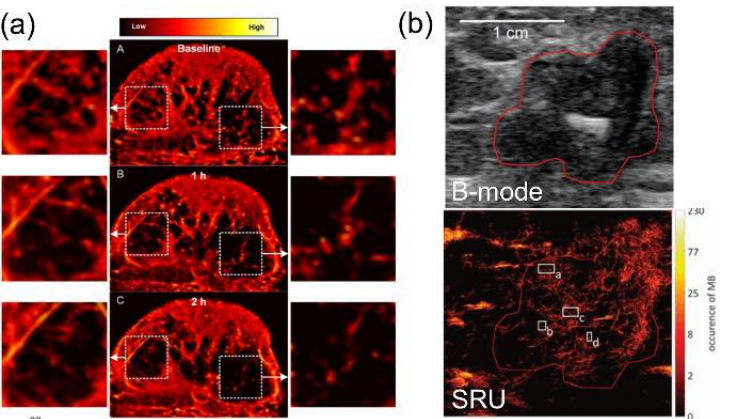
Figure 6. Representative SRU images of microvasculature from ( a ) breast cancer-bearing mice in response to the treatment (Reprinted with permission from ref. [70]. Copyright 2017 IEEE), and ( b ) the patient with triple-negative breast carcinoma. (Reprinted with permission from ref. [71]. Copy- right 2019 IEEE).